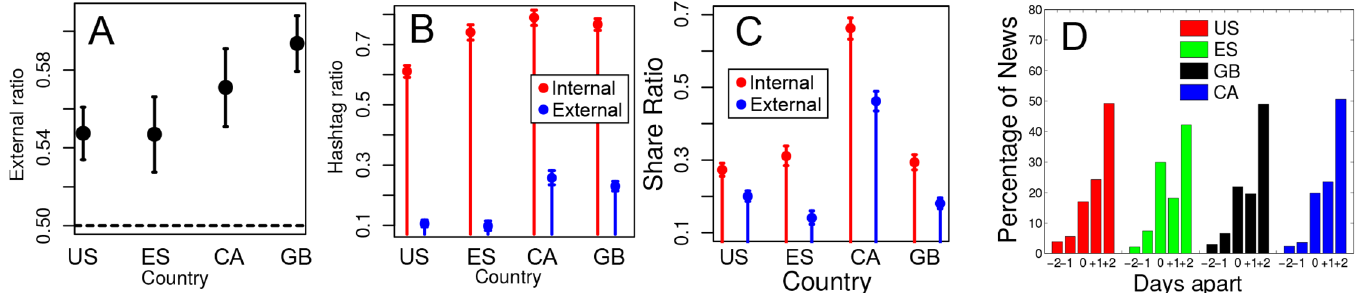
Fig 4. Properties of internal and external TTs. A) Ratio of External TTs; B) Ratio of External and Internal TTs that are hashtags; C) Conditional Probability of Internal or External TTs being shared; D) Percentage of news appearing in principal newspapers with some positive or negative delay with respect to Twitter TTs. All figures show the results of the analysis for US, ES, CA and GB. Error bars indicate the 95% confidence intervals from χ 2